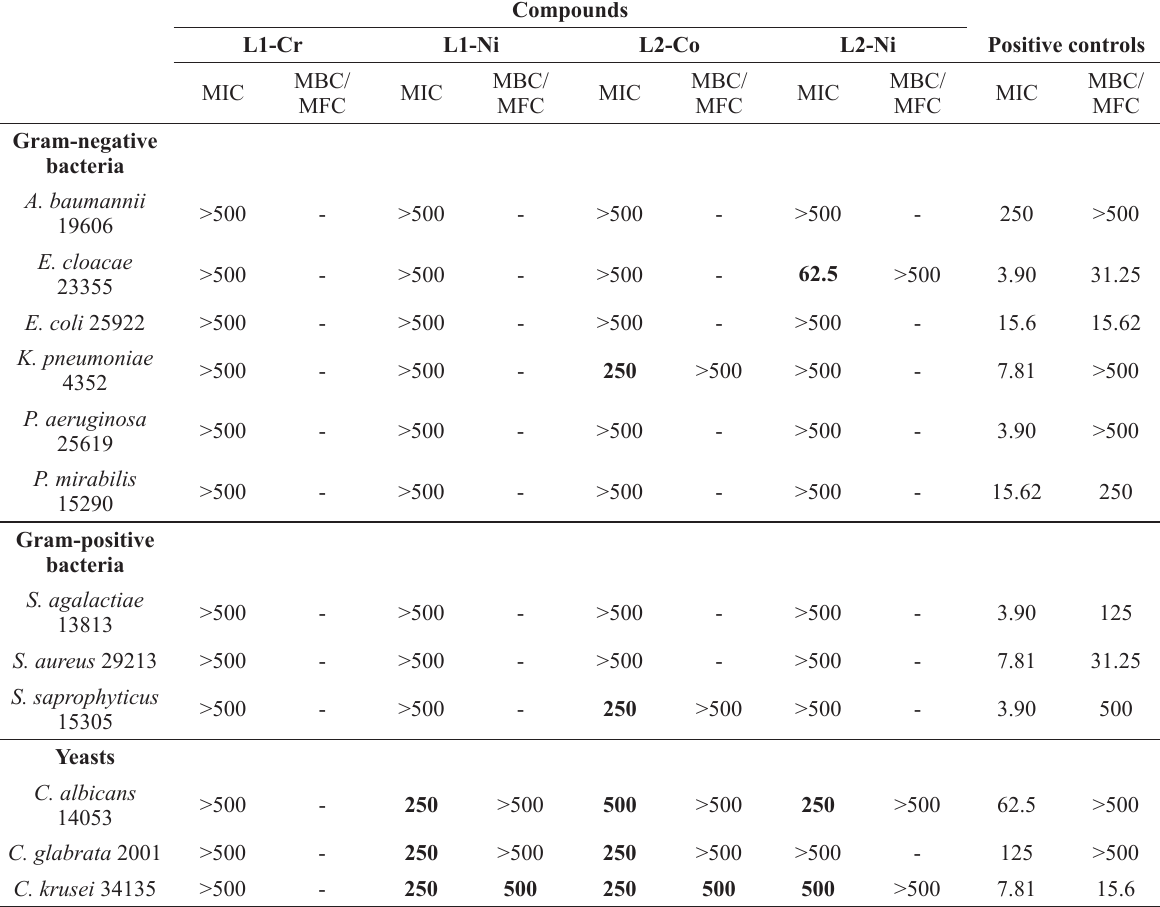
Antibacterial and antifungal activities showed by complexes and positive controls.